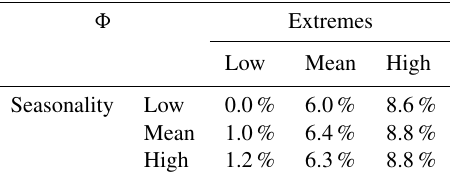
Table 7. Calculated skill scores, (cid:56) , for selection criterion S D for the nine different sensitivity scenarios listed in Table 1 calculated using Eq. (9).